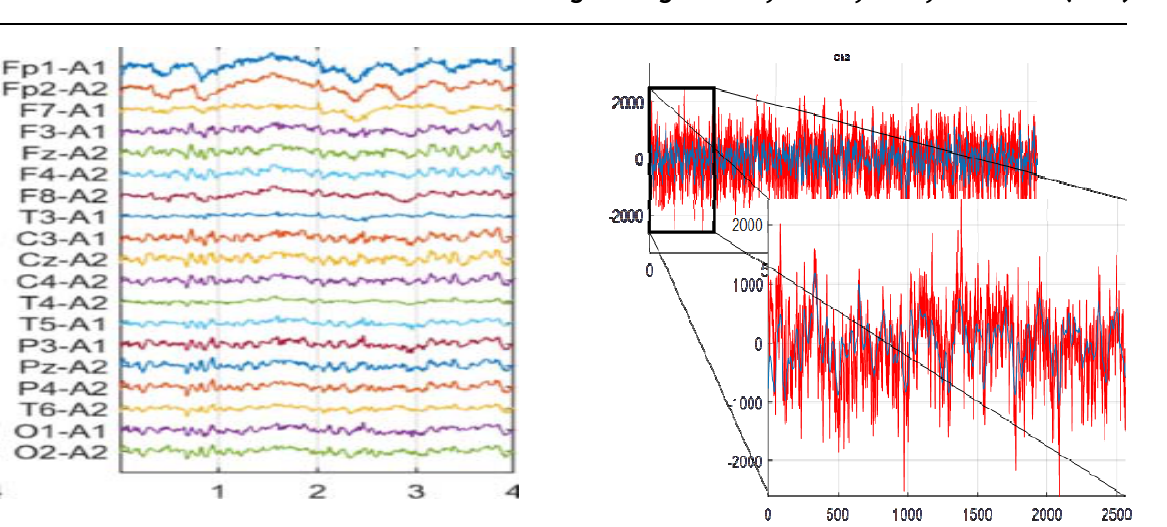
Fig. 4. After using SG filter for Ch2 which represent Fp2 to